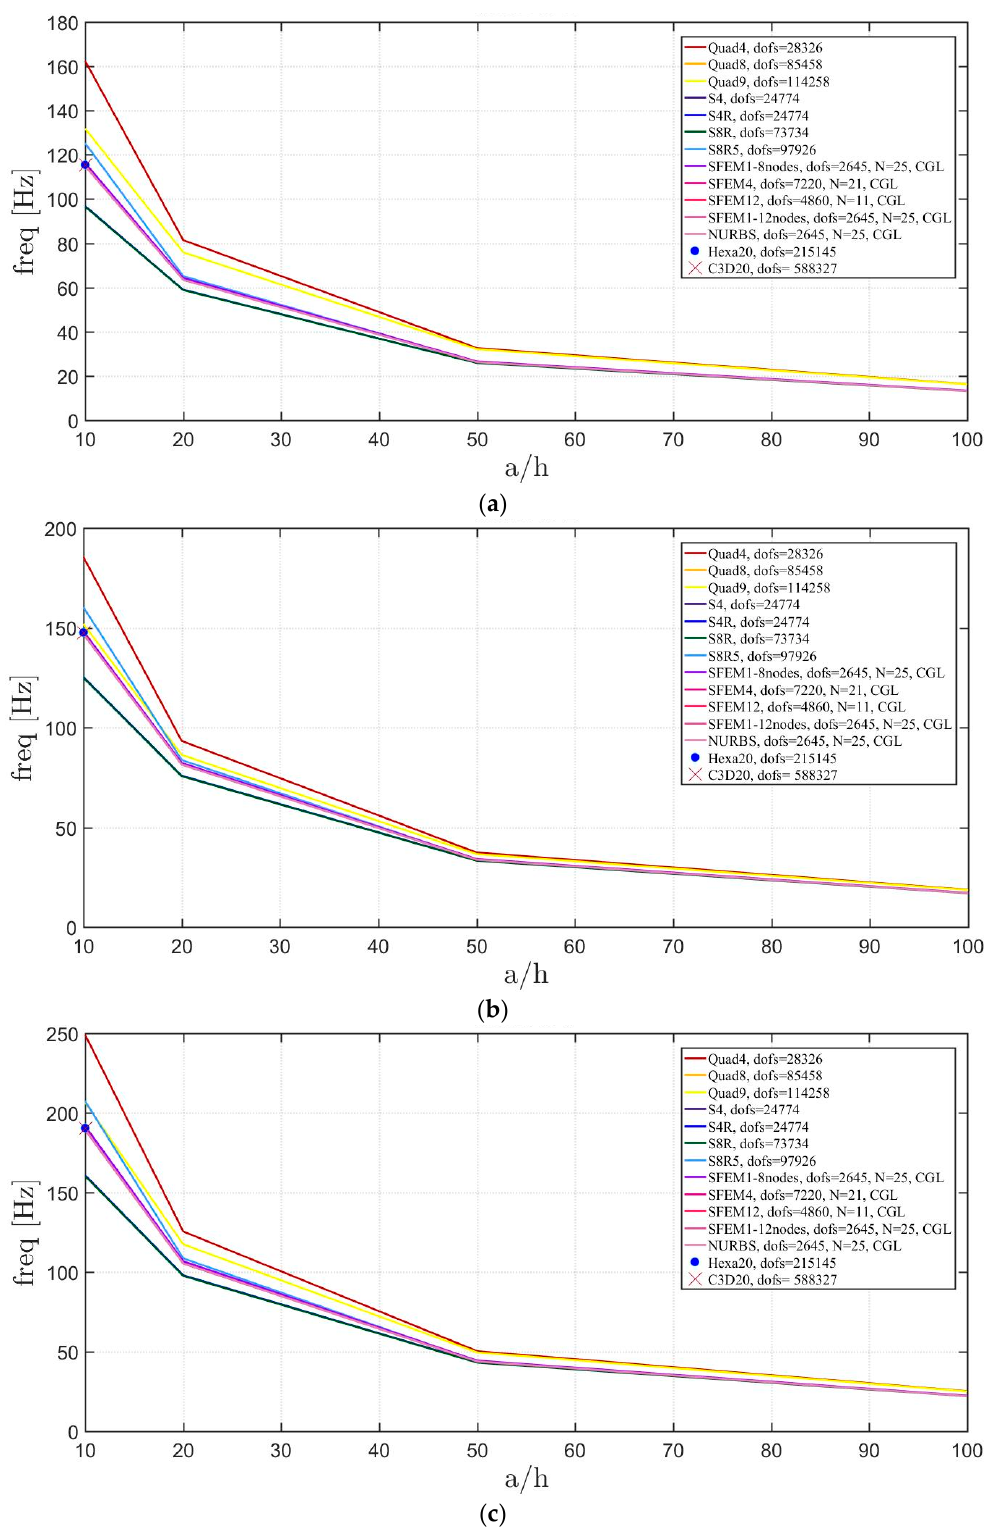
Figure 33. Thickness effect on the first three natural frequencies of an elliptic plate a / b = 2 with a not-symmetric lamination scheme: ( a ) First frequency; ( b ) Second frequency; ( c ) Third frequency.